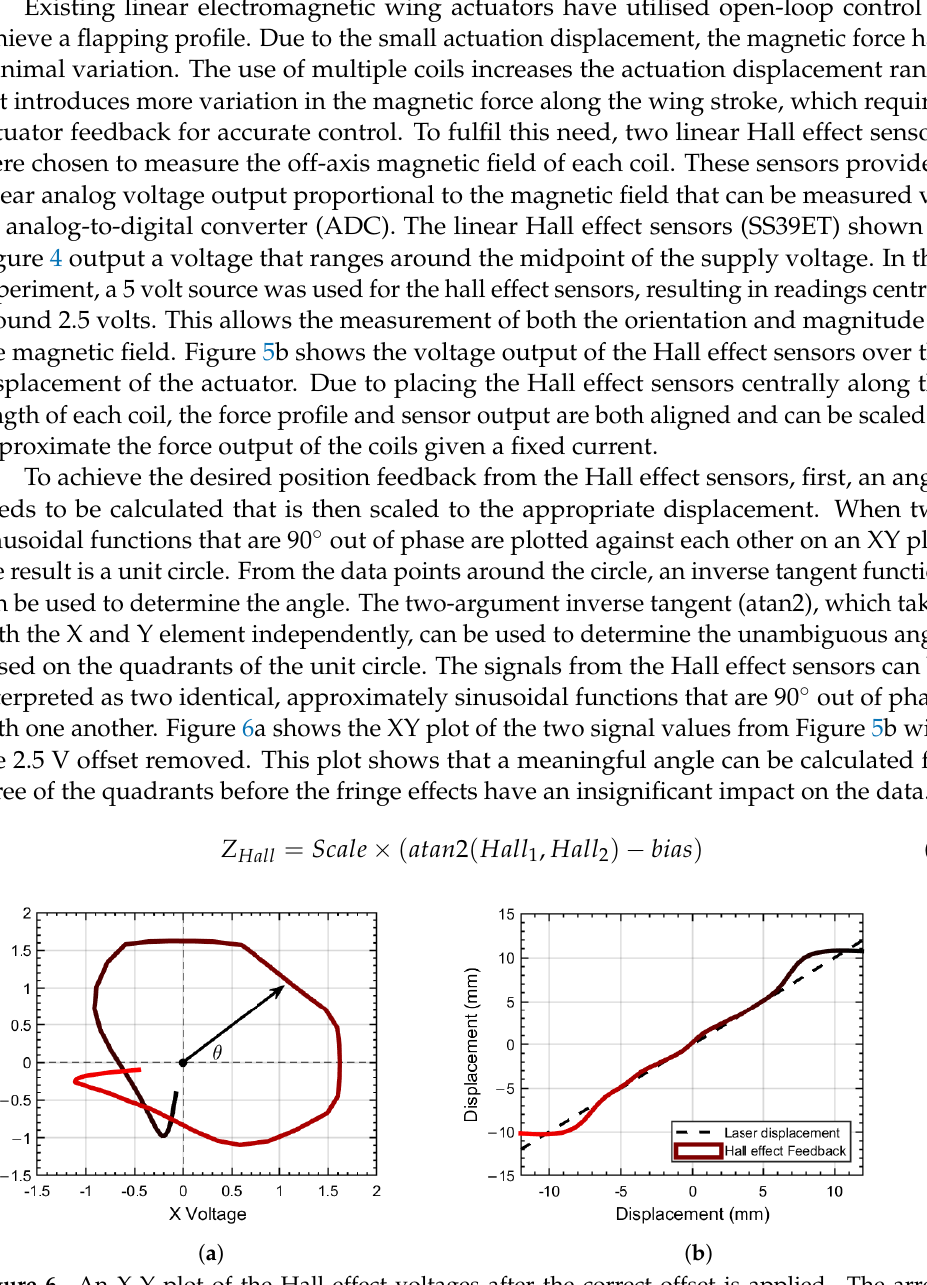
Figure 6. An X-Y plot of the Hall effect voltages after the correct offset is applied. The arrow demonstrates the unambiguous angle that can be calculated with the atan2 function ( a ), the scaled output of the atan2 function with appropriate wrapping calculating the magnet displacement from the Hall effect sensors compared to the ground truth of the laser displacement sensor ( b